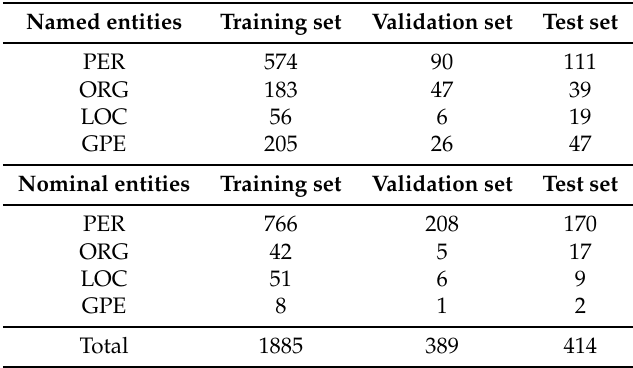
Table 2. The summary of the Weibo.